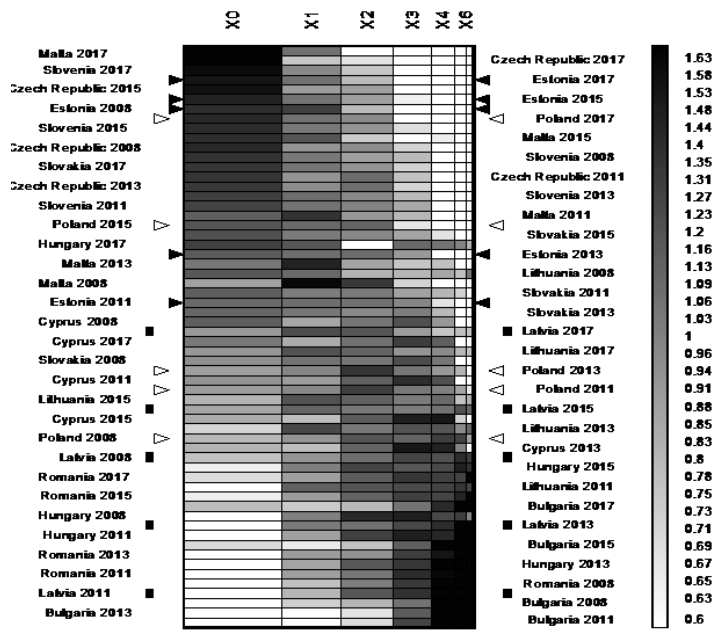
Figure 7. Overrepresentation map presenting the structures of the 12 new States due to the level of material deprivation. Source: own study.